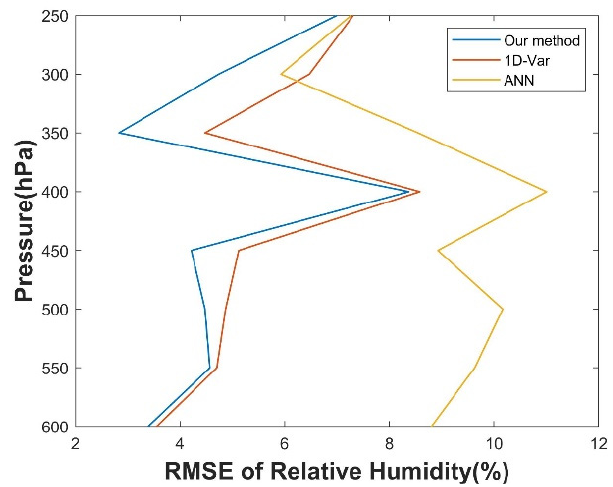
Figure 10. With ERA5 reanalysis data as the reference true value, the RMSE of the three methods (250–600 hPa).